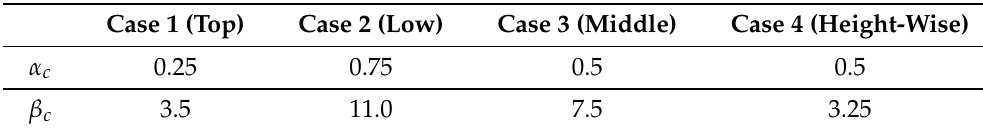
Table 1. Different pair values ( α c , β c ) of the parameters given to the Weibull distribution to define four distinguishable canopy shapes.